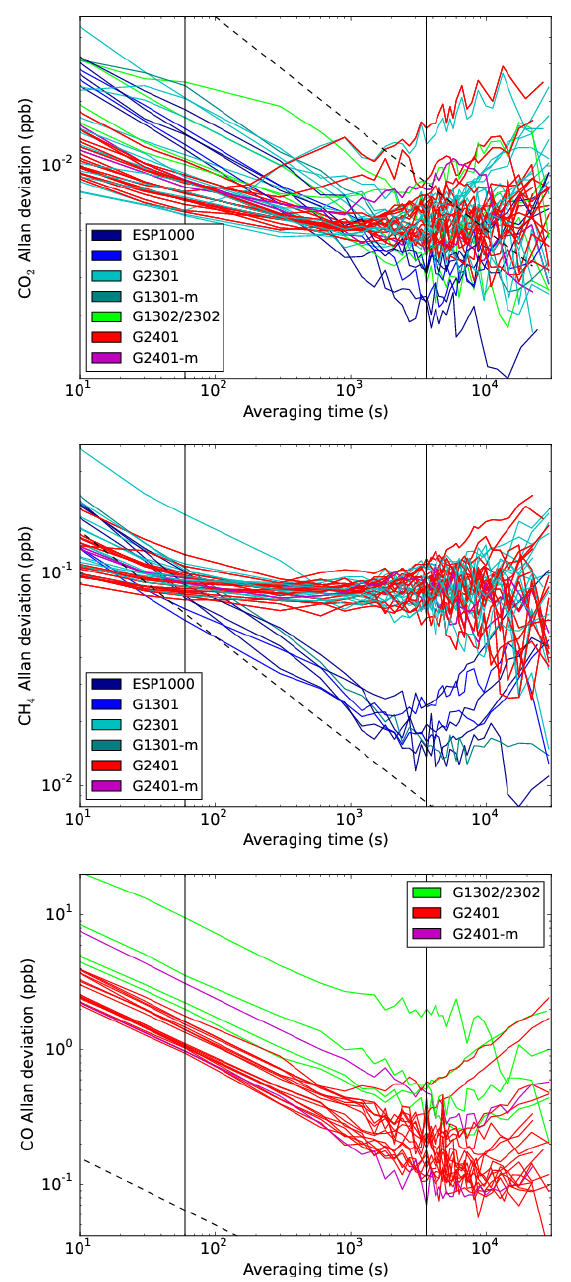
Figure 2. Allan deviation for CO 2 , CH 4 and CO. The vertical solid black lines show 1min and 1h averaging times. X and Y axes are in logarithmic scales. The black dotted line shows the white noise (cid:16) 1 (cid:17) √ 2 time